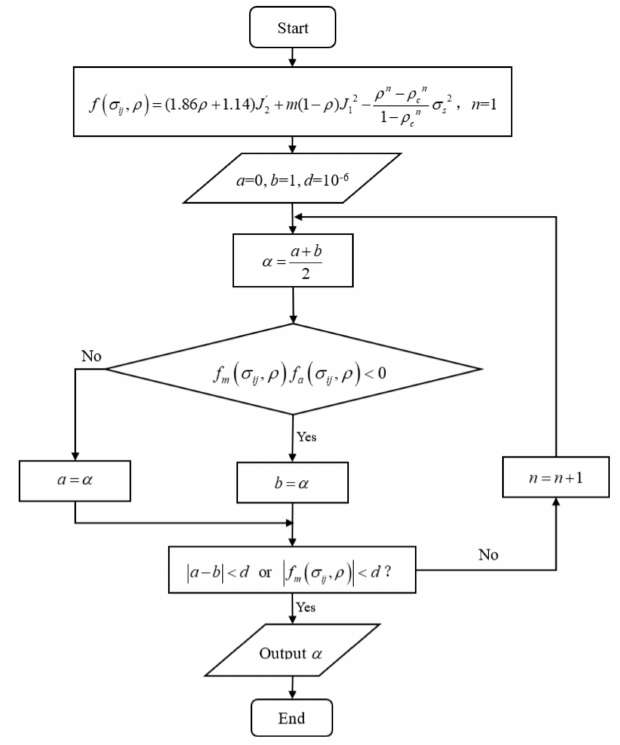
Figure 3. Flow chart of finding α by